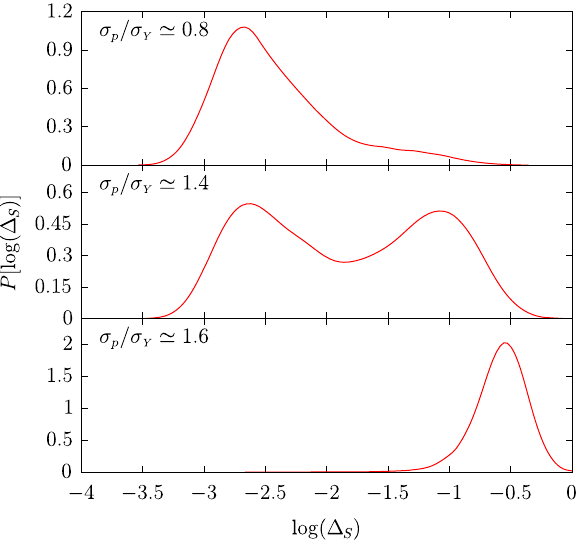
Þ for three s FIG. 8. Probability distribution functions for log j ˆ u s ð t Þj for the same values of the peak stress σ p reported in Fig. 6, where ˆ u s ð t Þ is the projection of the velocity field onto the viscous solution [see Eq. (3)] once elastic waves are filtered out [see Eq. (6)]. We obtain the same qualitative behavior as in Fig. 6, stressing the transition from the solid branch (top panel) to the plastically = σ ≃ 1 . 6 , only flowing one (bottom panel) passing through a regime where both p Y coexist (middle panel). See Fig.